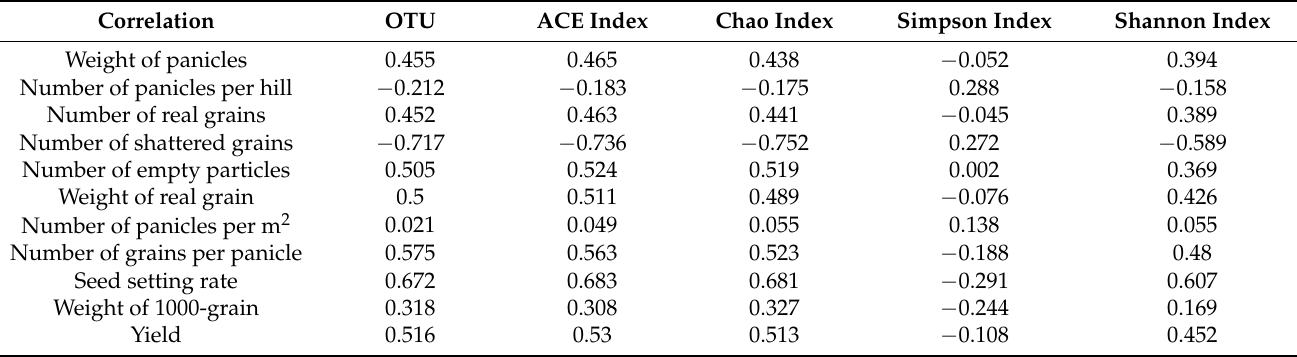
Table 9. Correlation between rice yield and alpha diversity of soil